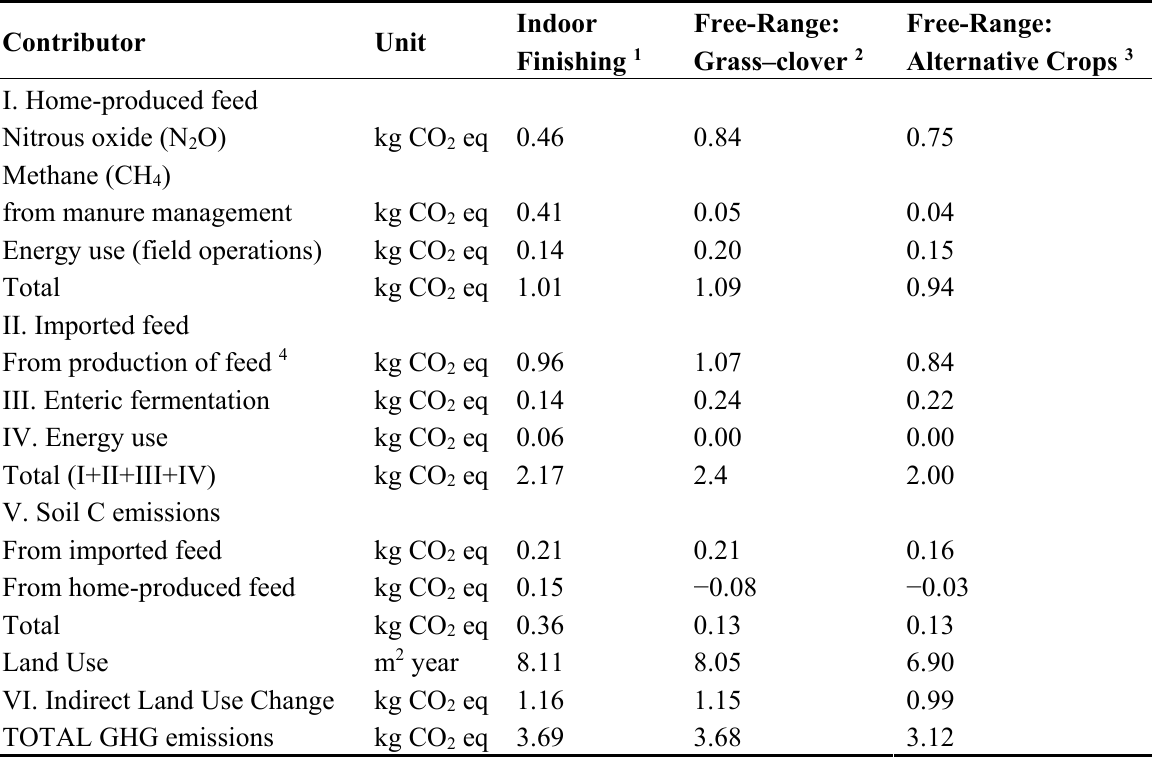
Table 7. Greenhouse gas emissions in three organic pig production systems presented per kg live pig